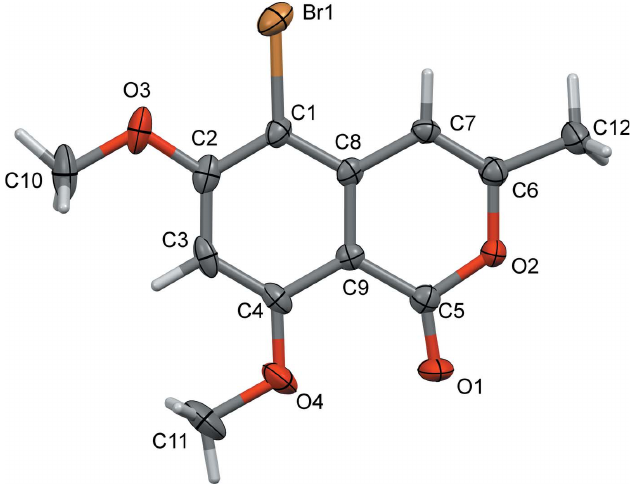
Figure 2 The molecular structure of compound II , with atom labelling. Displace-